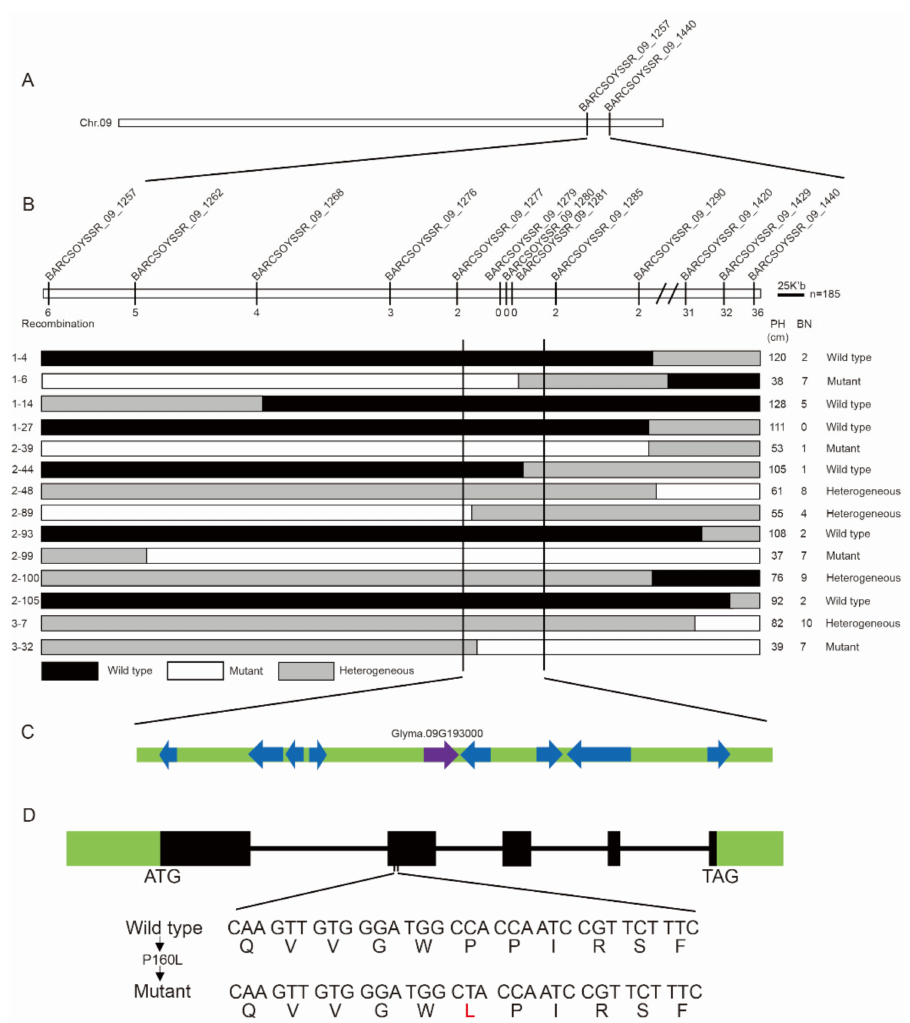
Figure 3. Map-based cloning of GmIAA27 in soybean. ( A , B ) Initial mapping of GmIAA27 using 185 plants from the F 2 population derived from the cross dmbn × Dengke1. ( C ) Annotation in the candidate region according to the soybean cultivar Williams 82 reference genome. Arrowheads indicate putative genes predicted in Soybase (https://soybase.org/gb2/gbrowse/gmax2.0/; accessed on 22 February 2020). ( D ) Structure of the GmIAA27 gene ( Glyma.09G193000 ). A single-nucleotide substitution (C–T) was identified in the second exon of the Glyma.09G193000 gene that converts a conserved Pro 160 to